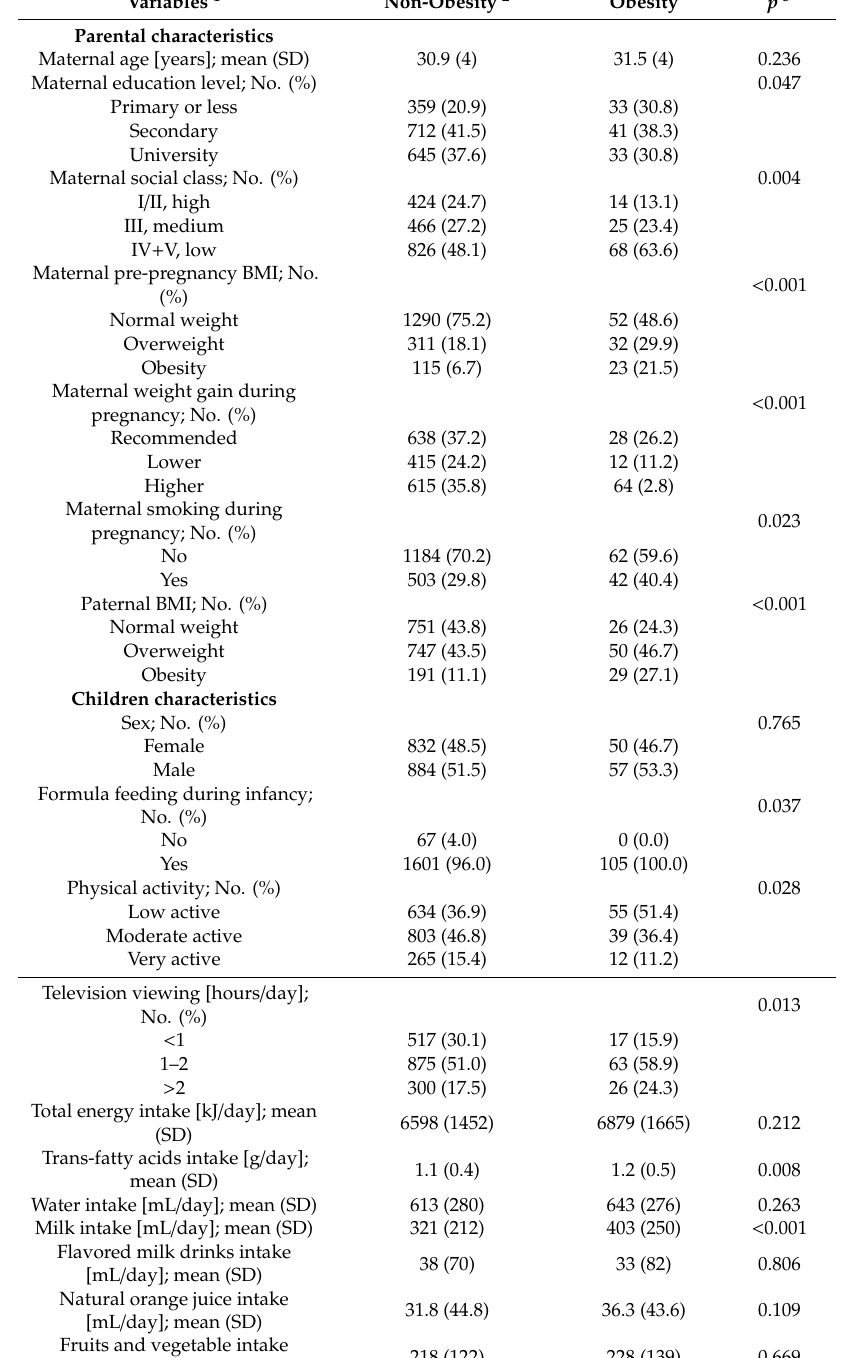
Table 1. Characteristics of the children at 4–5 years in the INfancia y Medio Ambiente (INMA) Study according to their obesity